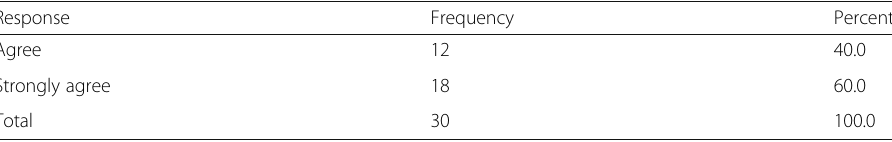
Table 9 Use of freight monitoring system Response Frequency